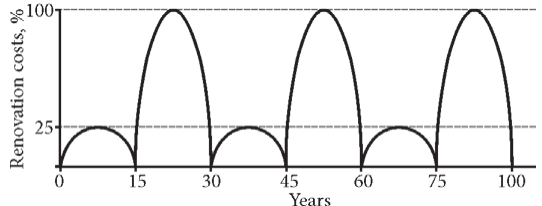
Fig. 4. Example – maintenance cycles for the structural element of the bridge Table 1. The matrix of maintenance and renewal cycles Time (years)/